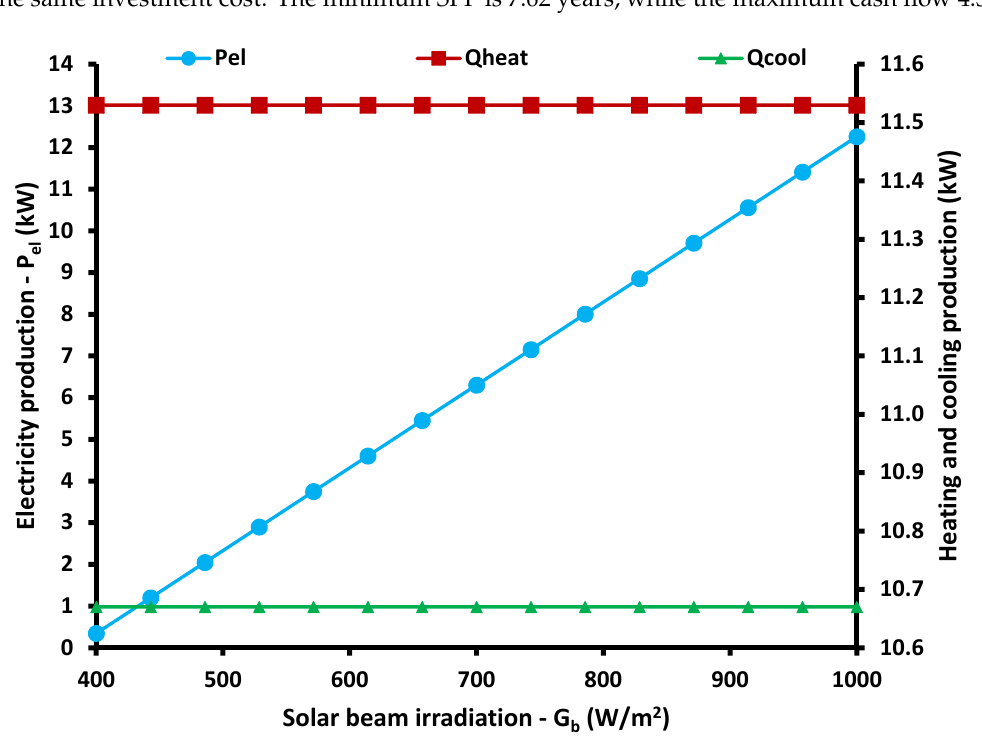
Energies 2020 , 13 , x FOR PEER REVIEW Figure 17. Electricity, heating, and cooling for di ff erent solar irradiation levels. Figure 17. Electricity, heating, and cooling for different solar irradiation levels.